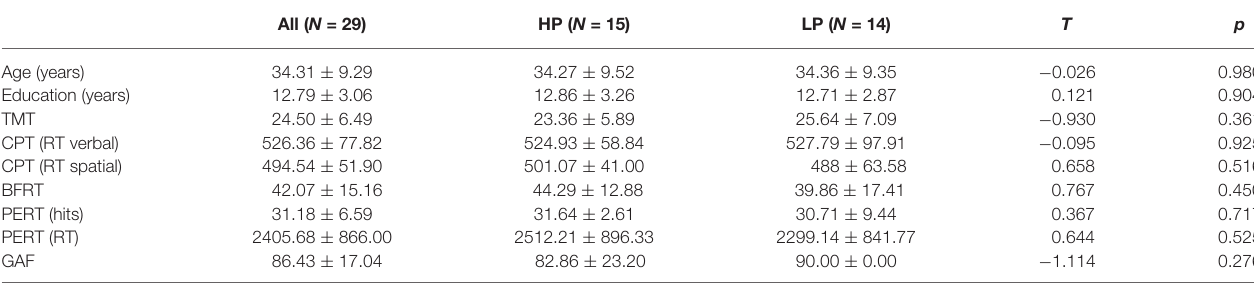
TABLE 1 | Demographic and neuropsychological characteristics of the